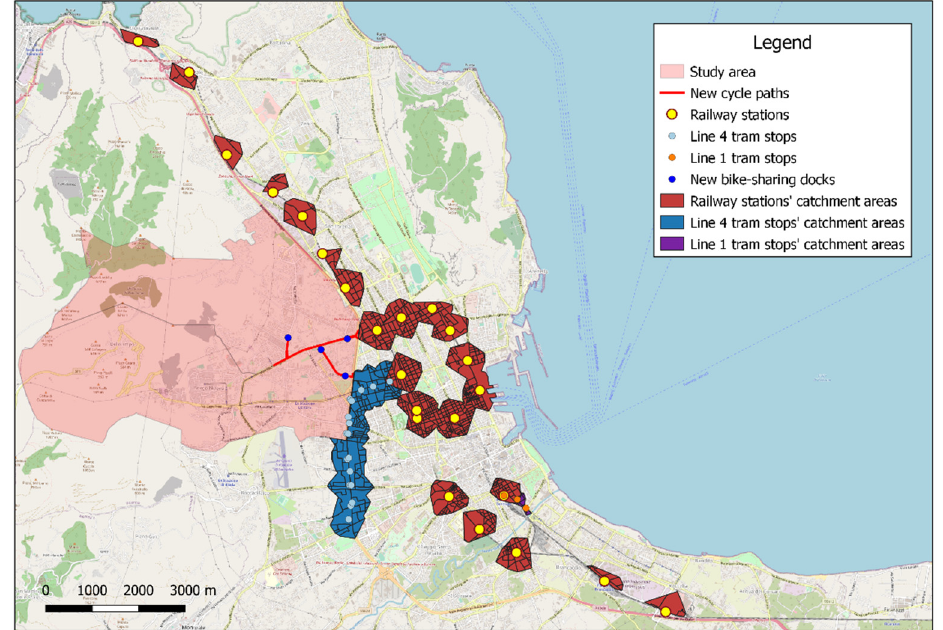
Figure 8. The railway stations’ and the tram stops’ catchment areas.